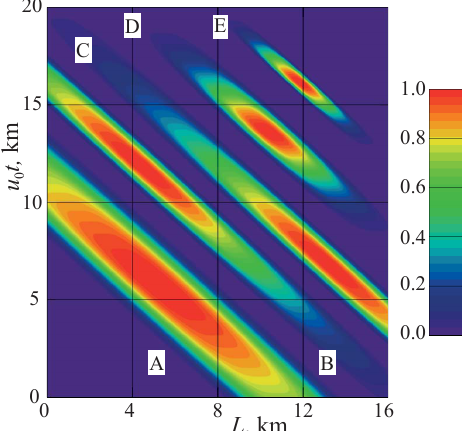
Figure 3. Lidar images J A (L,t) of aerosol clusters simulated ac- cording to the model (Eq. 6) for a constant beam direction aligned with the flight trace. The scale of J A is given in pseudo-color on the left. The vertical axis corresponds to the product of u 0 t 0 , where t 0 is a sensing pulse generation point and u 0 is the aircraft